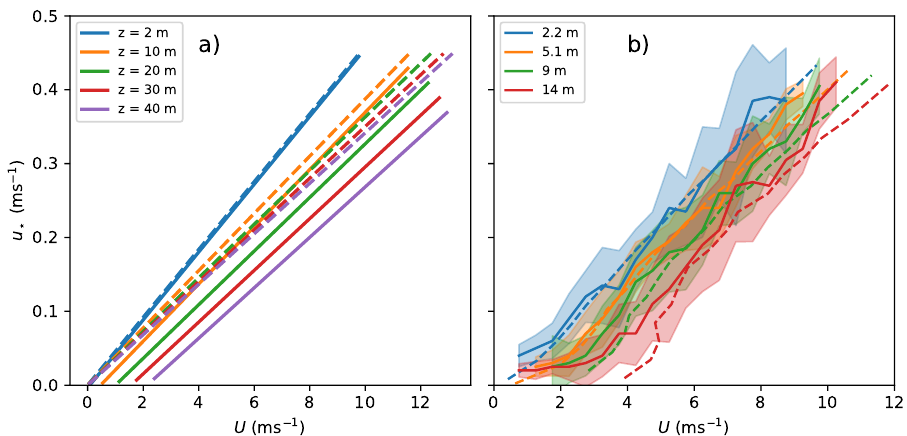
Figure A1. The u (cid:63) − U relationship for neutral stratification ( a ) based on the logarithmic law (Equations (2) and (25)) and for the observed values of the stability parameter z / L 0 during SHEBA ( b ) based on observations (solid curves) and the extended MOST (dashed